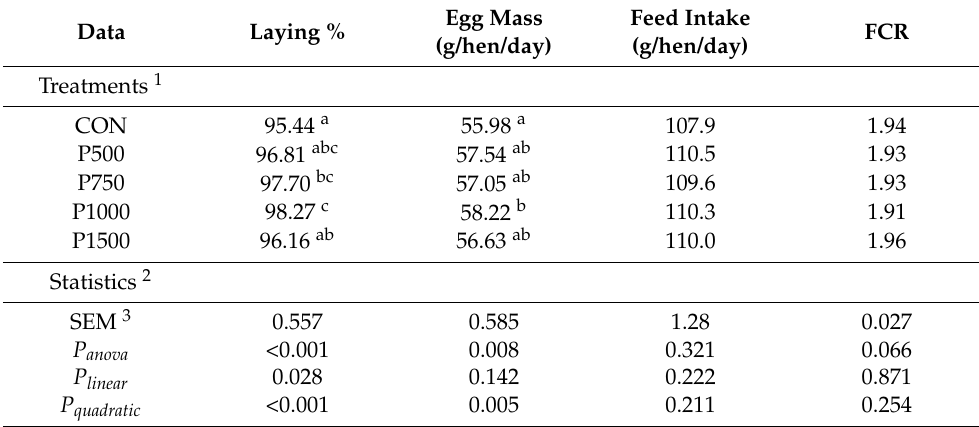
Table 3. Overall performance parameters of laying hens for weeks 1 to 12 of the